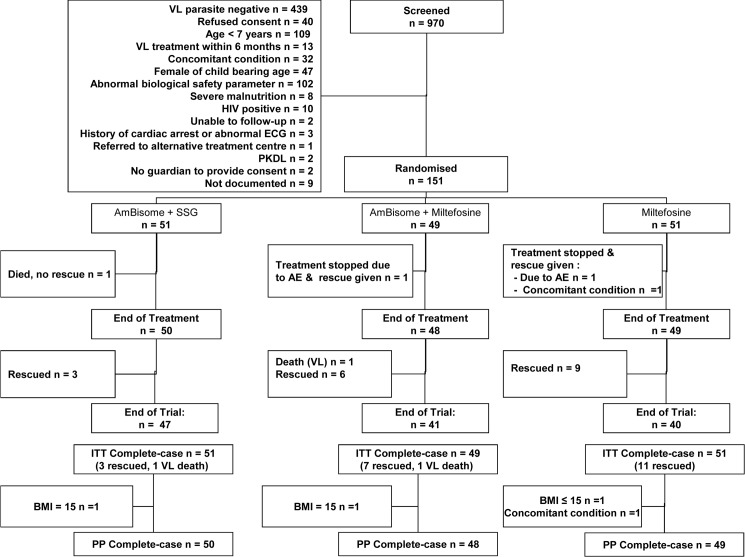
Participant Flow.